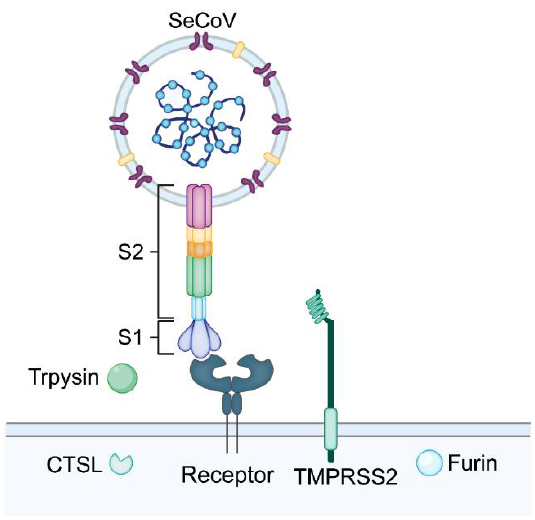
Figure 3. Attachment and entry of SeCoV. Schematic diagram showing the attachment and entry processes assisted by the host proteases of SeCoV. The S1 region of SeCoV’s S protein binds to specific receptors, and the S2 region helps the virus integrate with the cell surface. The host proteases cleave the S protein to facilitate membrane fusion and allow the virus to enter the cell.